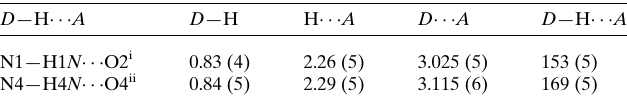
Figure 9 Molecular packing of